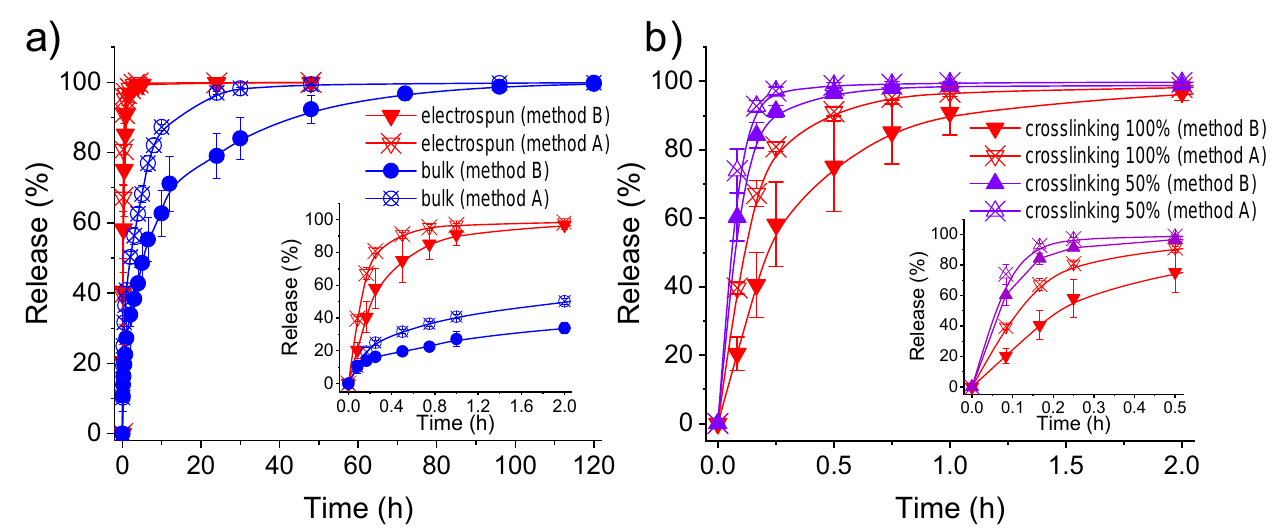
Figure 9. Accelerated release of triclosan from hydrogels in a PBS-ethanol (70v:30v) medium. ( a ) TCS relative release percentages for electrospun and bulk hydrogels; both with a crosslinking degree of 100%. ( b ) TCS relative release percentages for electrospun hydrogels with different crosslinking percentages. In both graphics, methods A and B refer to the loading of TCS by absorption or during the crosslinking process, respectively. Insets show release determined at initial times. Table 3. Release kinetic parameters for γ -PGA hydrogels loaded with antibacterial drugs. Drugs were loaded by absorption (method A) or during the crosslinking reaction (method B). r, correlation coefficient. EC, encapsulation according to Equation (2).